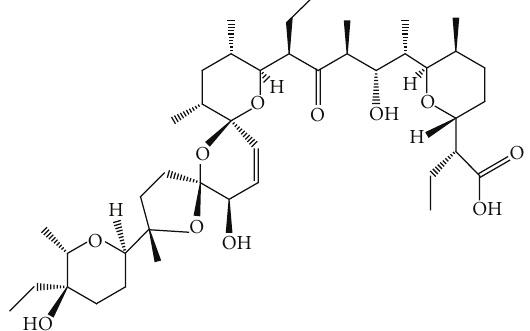
Figure 1: Structural formula of salinomycin. The pentacyclic molecule with a unique tricyclic spiroketal ring system has a mass of 751 Da, a molecular formula of C 42 H 70 O 11 , a melting point of 113 ◦ C, and a UV absorption at 285 nm. Adapted from [102, 103], with permission from Elsevier